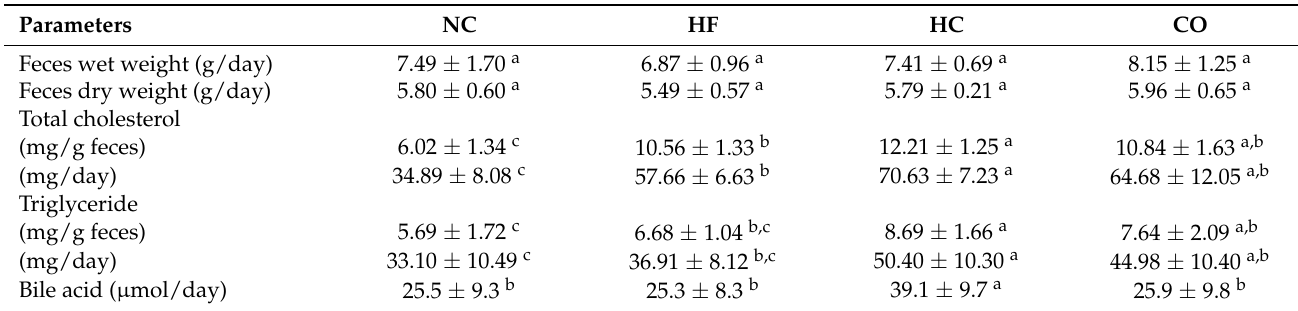
Table 5. The changes in fecal weight and levels of total cholesterol and triglyceride in rats fed with the different experimental diets after 12